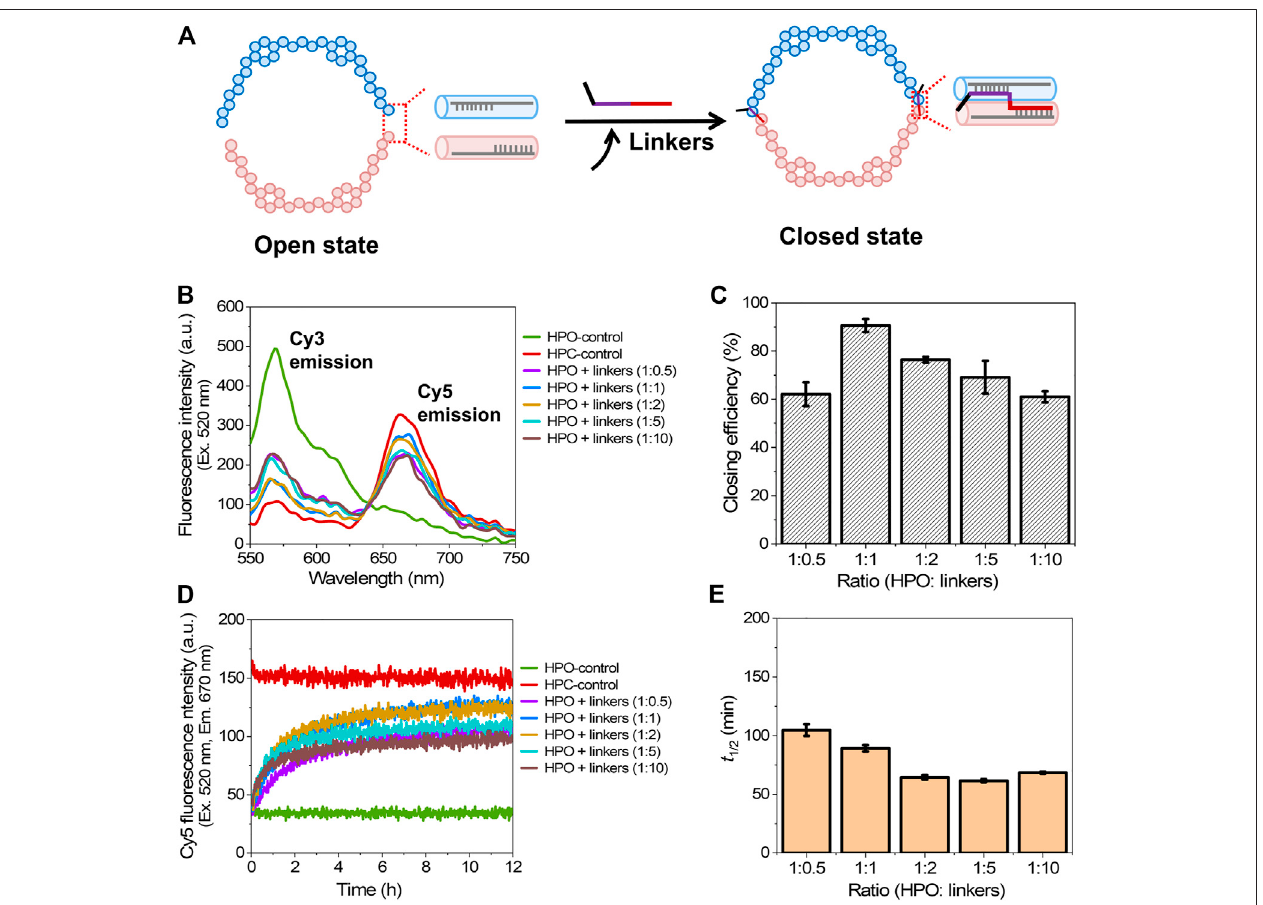
FIGURE 2 | Closing process of the DNA scaffold. (A) A schematic representation of the closing mechanism through hybridization of the closing linkers to both the facing edges of two domains. Six types of single-stranded linkers were utilized to fully close the scaffold. (B) Fluorescence emission spectra ( λ ex (cid:2) 520 nm) after incubationfor12 hwithvarious molarratios oftheclosing linkers at25 ° C. (C) EffectofthemolarratioofHPO totheclosing linkers(HPO: linkers)ontheclosing ef fi ciency at 25 ° C. (D) Time course changes of the Cy5 fl uorescence intensity ( λ ex (cid:2) 520 nm, λ em (cid:2) 670 nm) during the closing process at various molar ratios of linkers at 25 ° C. (E) Half time ( t 1/2 ) of the closing process in (D) . Hybridization conditions: 5 nM HPO wasincubated with 2.5 – 50 nM linkers in the buffer (pH 7.0) containing40 mM Tris-HCl, 20 mM acetic acid, 12.5 mM MgCl 2 , and 0.002% Tween 20 at 25 ° C for 12 h.